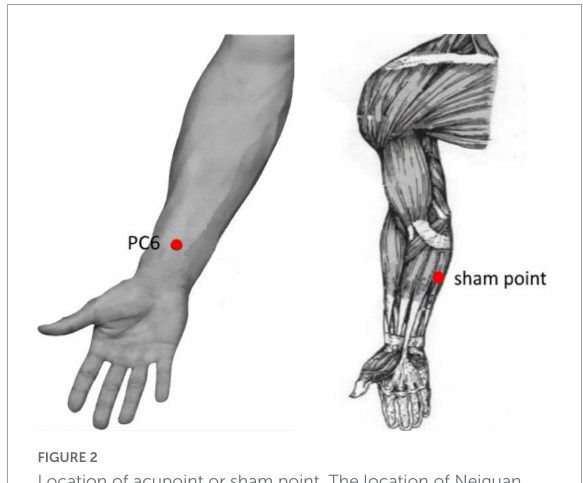
FIGURE2 Location of acupoint or sham point. The location of Neiguan (PC6) acupoint is 2 cm above the transverse crease of the wrist, between the tendons of m. palmaris longus and m. flexor carpi radials. The sham point is on the ulnar side of the arm, midway between the epicondylus medialis of the humerus and the ulnar side of the wrist.